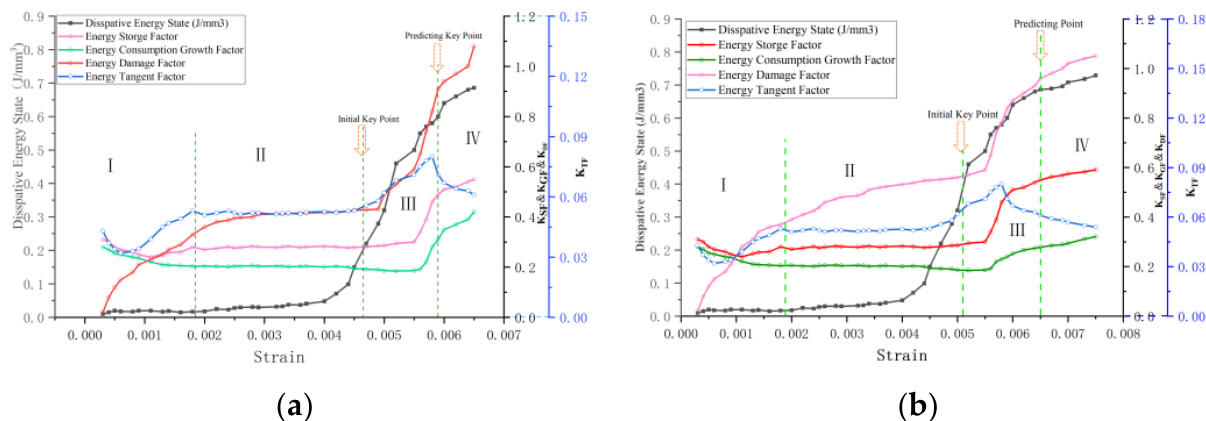
Figure 16. The energy behaviour predicting pattern of the coal failure process. The green line is